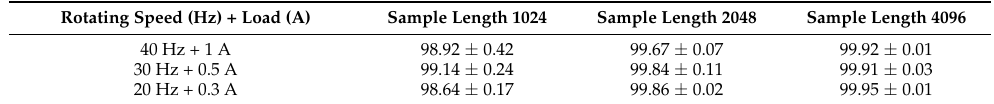
Table 5. Average accuracy (%) of SRMANet for different